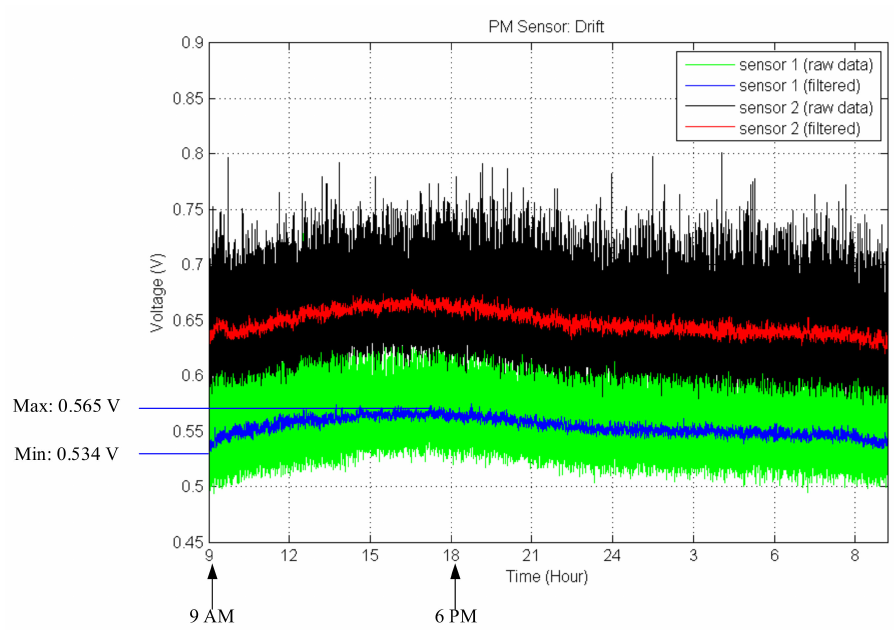
Figure 8. Drift experiment over